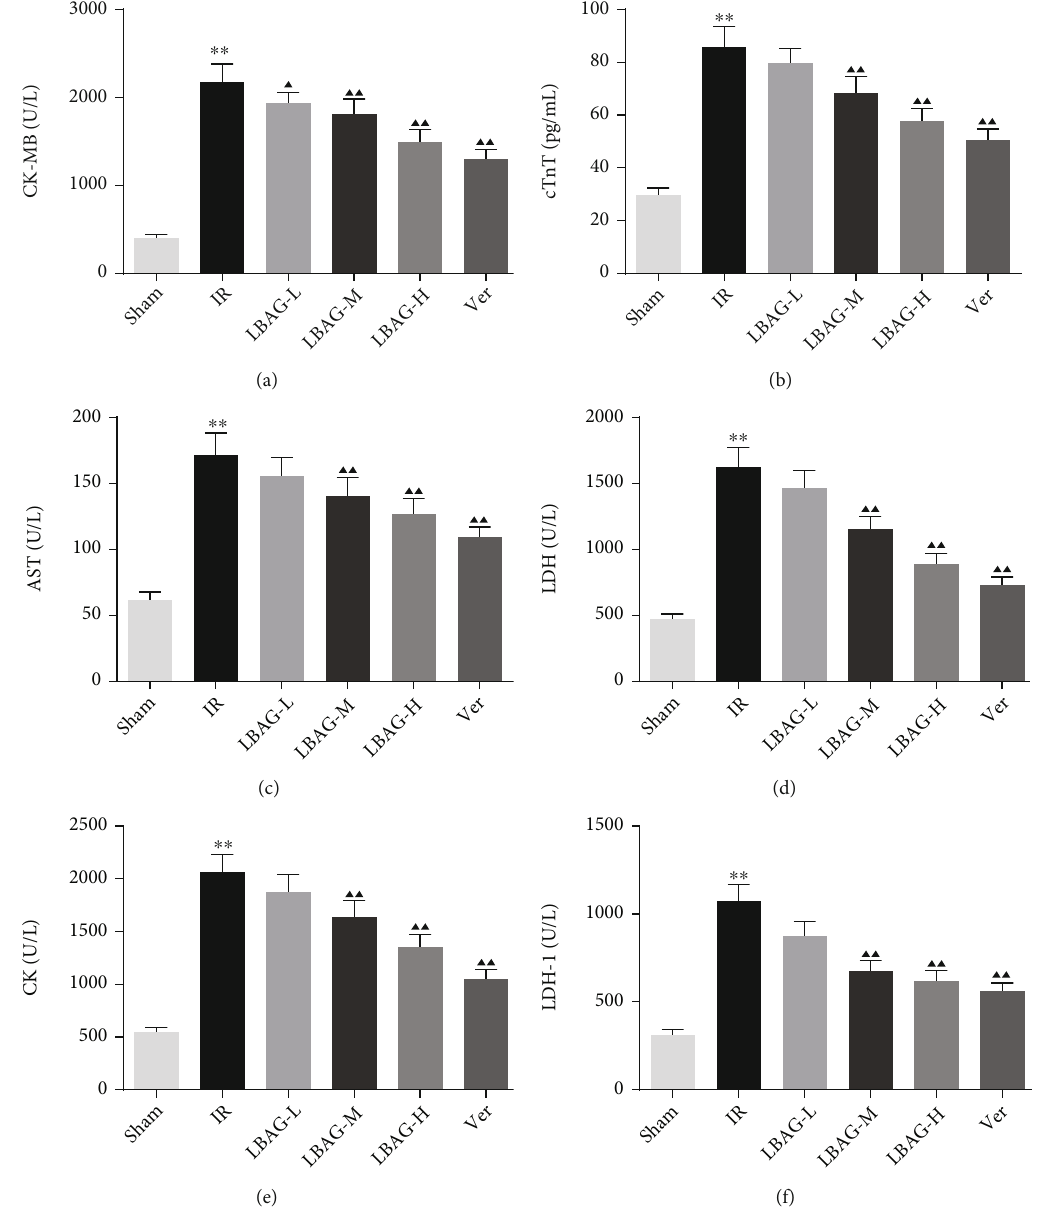
Figure 2: E ff ect of LBAG on cardiac damage markers in rats. The level of (a) CK-MB, (b) cTnT, (c) AST, (d) LDH, (e) CK, and (f) LDH-1 in the serum of rats with myocardial injury after LBAG treatment. ∗ P < 0 : 05 and ∗∗ P < 0 : 01 vs. sham group. ▲ P < 0 : 05 and ▲▲ P < 0 : 01 vs. IR